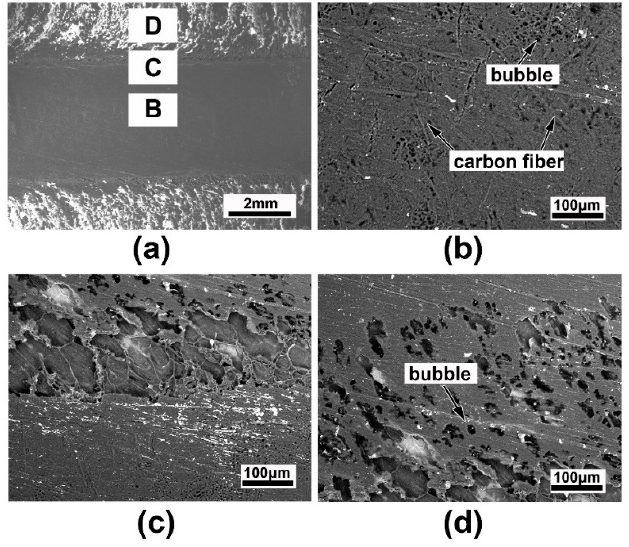
Figure 8. The microstructure of the joint under the power of 550 W and welding speed of 10 mm/s. ( a ) the bonding area appearance; ( b – d ) the structures corresponding to the area of B, C, D marked in ( a ).